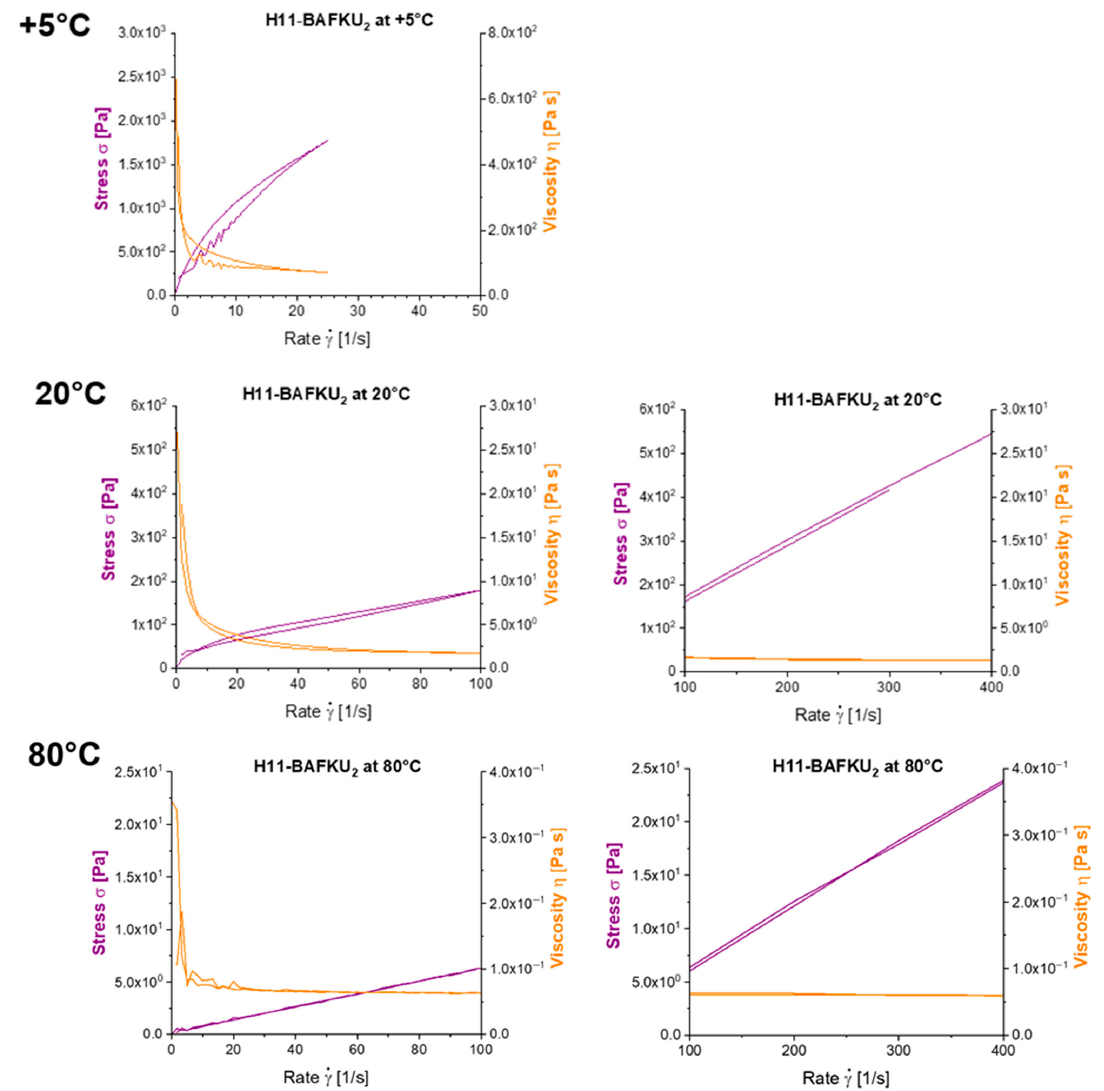
Figure 11. Thixotropic loop tests (dependence of shear stress and of viscosity on the shear rate) for the copolymer H11–BAFKU 2 at + 5, 20 and 80 ◦ C: at the left are continuous tests with shear rates rising up to 100 s − 1 , at the right are step-wise tests with shear rates between 100 and 400 s − 1 . Figure 11. H03–BAFKU 2 : The shortest copolymer, H03–BAFKU 2 (see results in Figure S22), displays